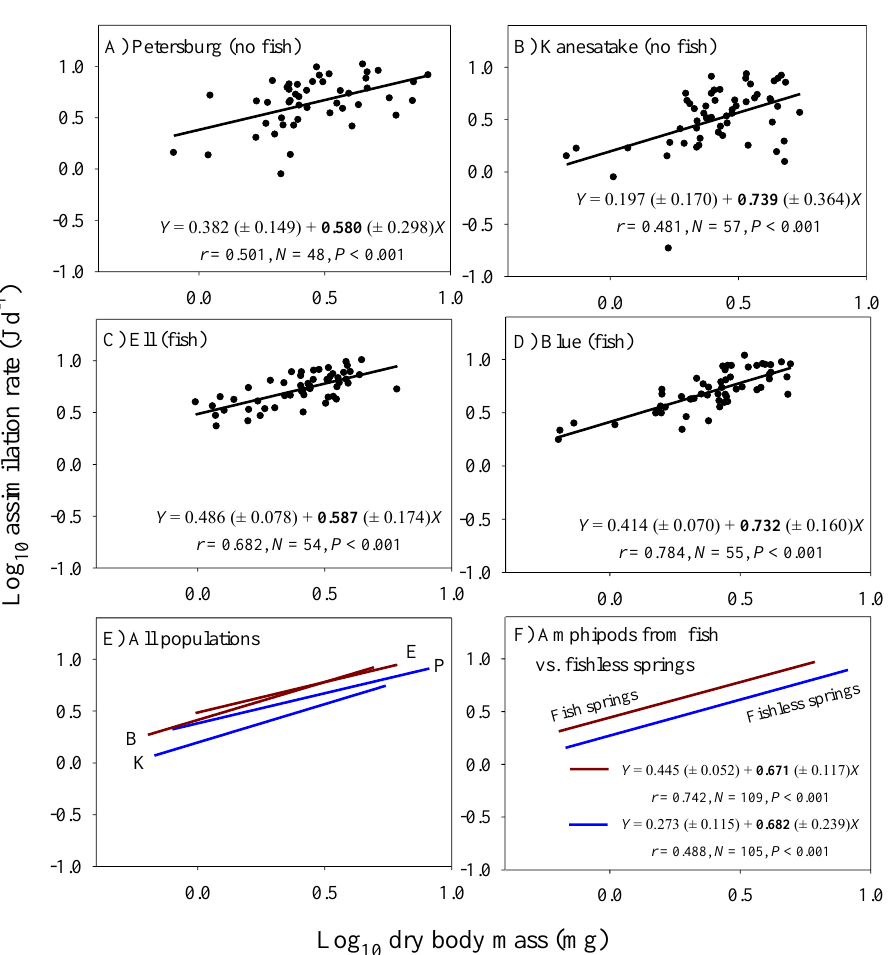
Figure 1. Log 10 food-energy assimilation rate in relation to log 10 dry body mass in four populations of the amphipod Gammarus minus . Least squares regression lines and equations are shown (numbers in parentheses are 95% confidence intervals for the intercepts and slopes; r = correlation coe ffi cient; N = sample size; P = probability that the correlation is due to chance). Scaling relationships for two populations in springs without fish predators ( Cottus cognatus ) ( A , B ), for two populations with fish predators ( C , D ), for all four populations compared ( E ), and for the populations with versus without fish, each analyzed collectively ( F